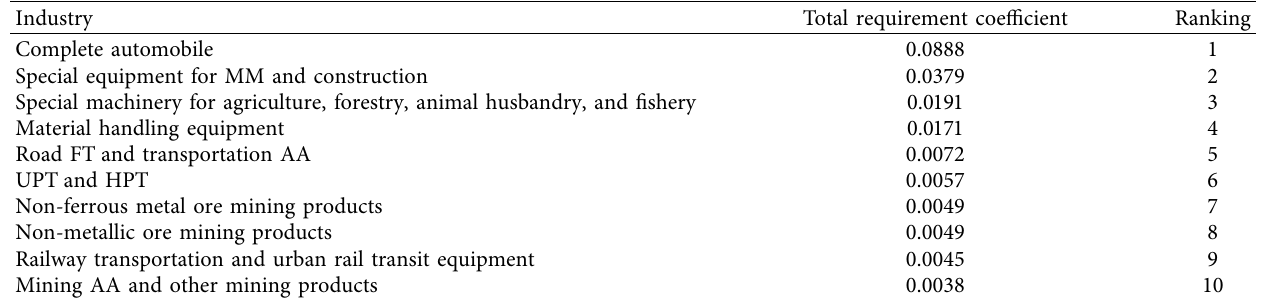
Table 7: Top 10 Industries for total requirement coefficient.